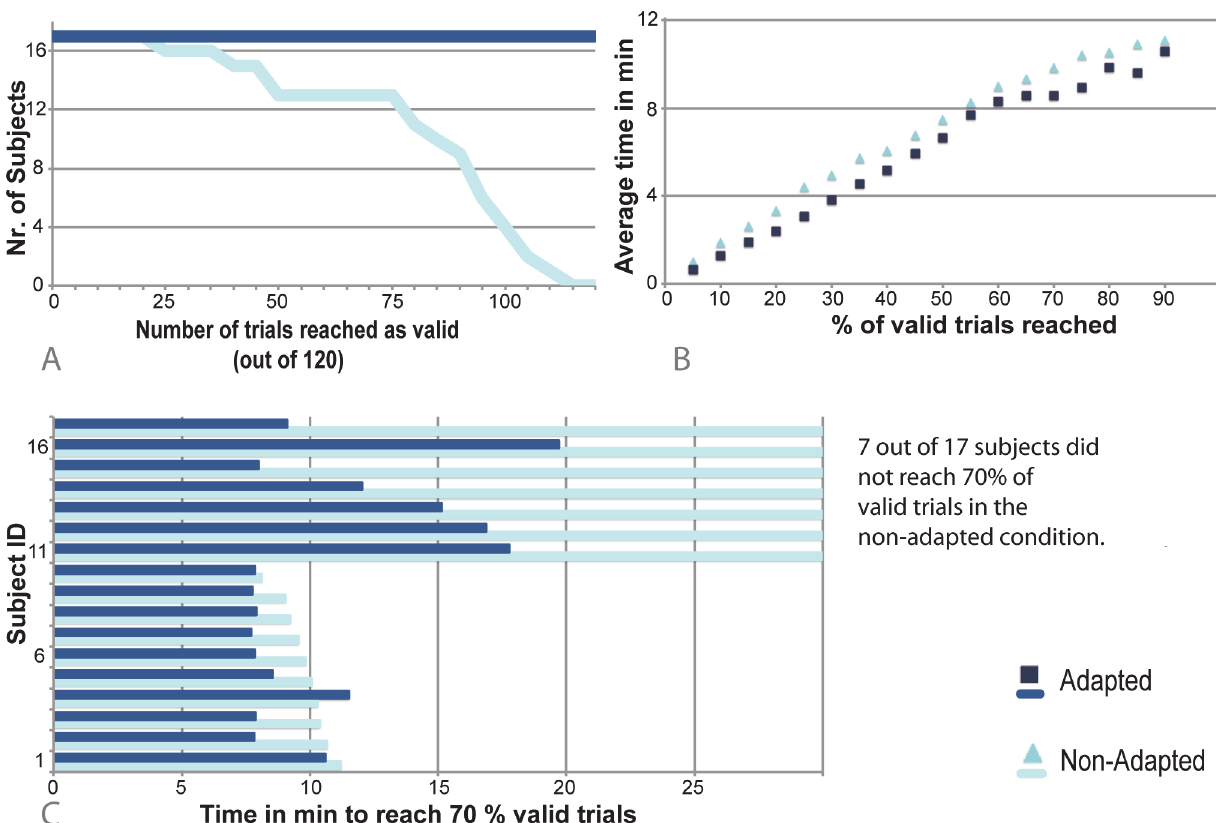
Fig 5. Comparison of experiment timing adapted and non-adapted condition. Individual rates of the amount of trials reached as valid regarding the fixation compliance (A); Overall comparison of time that was needed to reach a certain amount of valid trials. For 95% and 100% valid trials none of the subjects reached these amounts in the non-adapted manner, therefore comparison is not shown (B); Exemplarily, the individual results for this with the threshold of 70% valid trials. 7 out of 17 subjects did not reach this amount of valid trials in the non-adapted condition. 9 out of the 10 remaining subjects need less time in the adapted condition (C). In summary, the adaption of the stimulation can help to minimize measurement time and dropout of subjects.